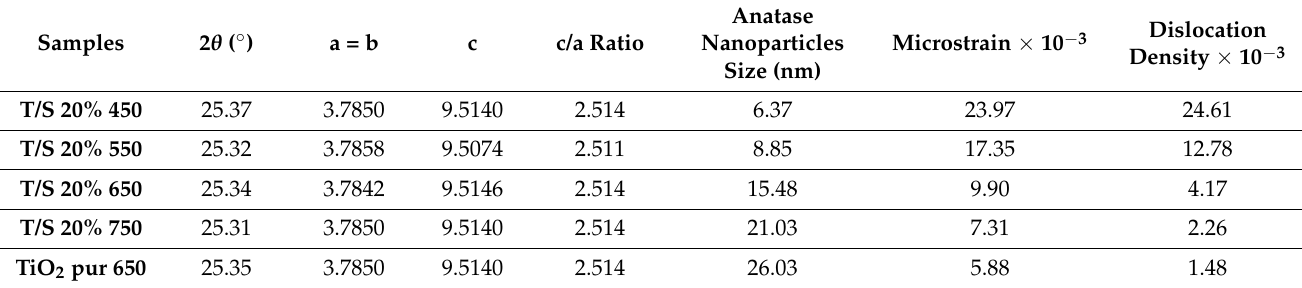
Table 1. Crystallographic parameters of the synthesized